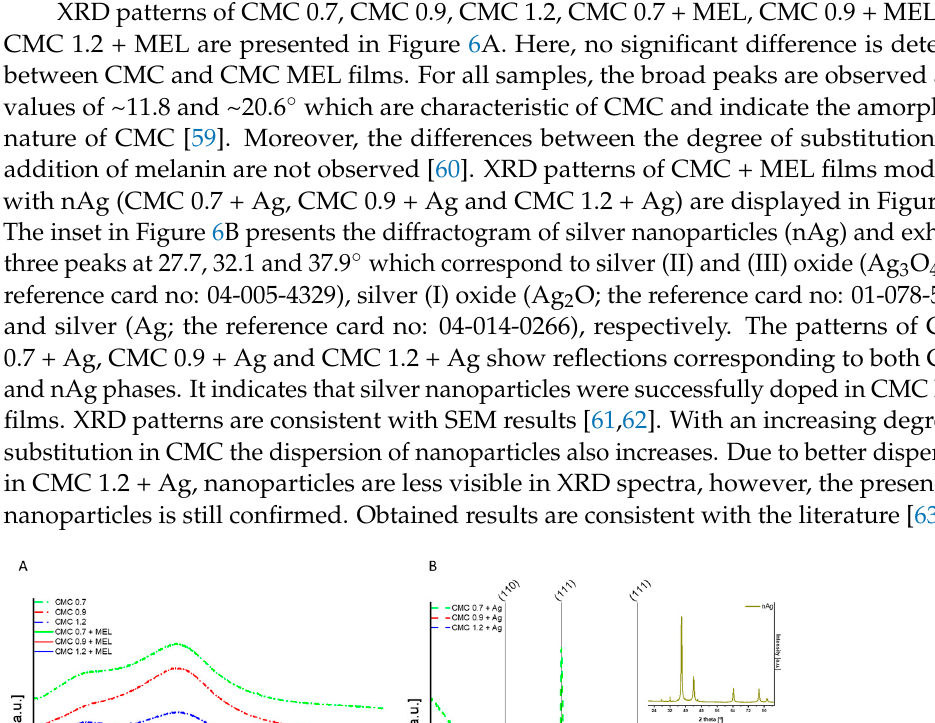
Figure 5 . SEM images of silver particles in lower ( A ) and higher ( B ) magnification and ( B ) size distribution.